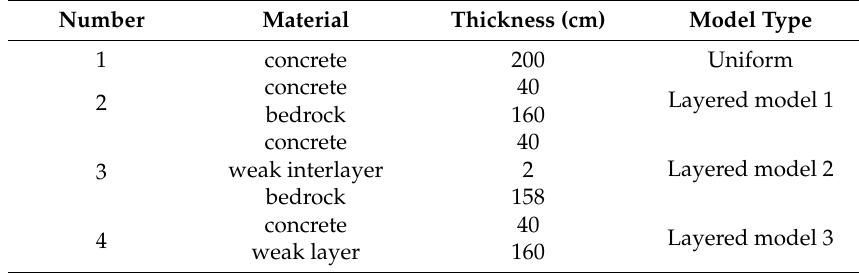
Figure 5. Layered model 2 (concrete-weak interlayer-bedrock). Table 1. Model schemes.